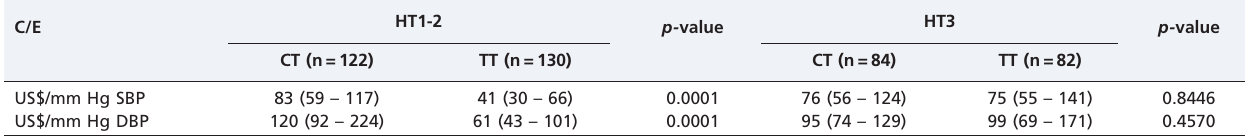
Table 2 - Cost-effectiveness (C/E) ratios based on the purchase prices of the brand-names in patients with grade 1 or 2 (HT1-2) or grade 3 (HT3) hypertension. The data were analyzed according to the antihypertensive regimen used [i.e., the traditional treatment (TT) versus the current treatment (CT)]. C/E HT1-2 p- value